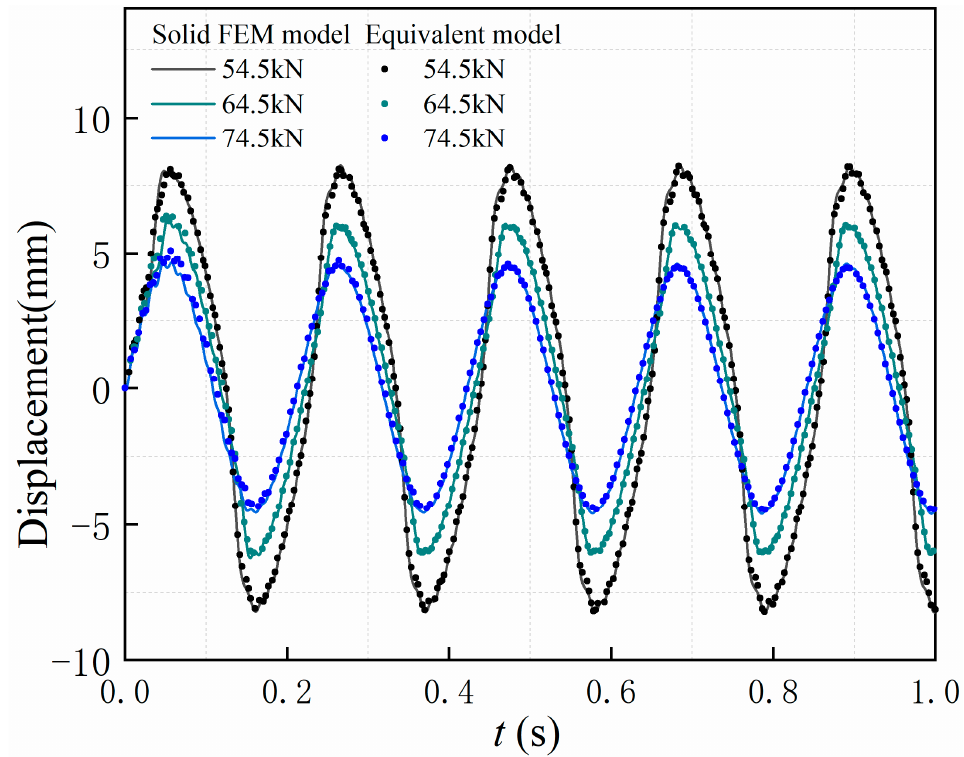
Figure 21. Responses of the equivalent model and the solid FEM model under different preload levels, F 0 = 500 N, ω = 30 rad/s. Table 5. Steady-state response amplitude under different excitations.